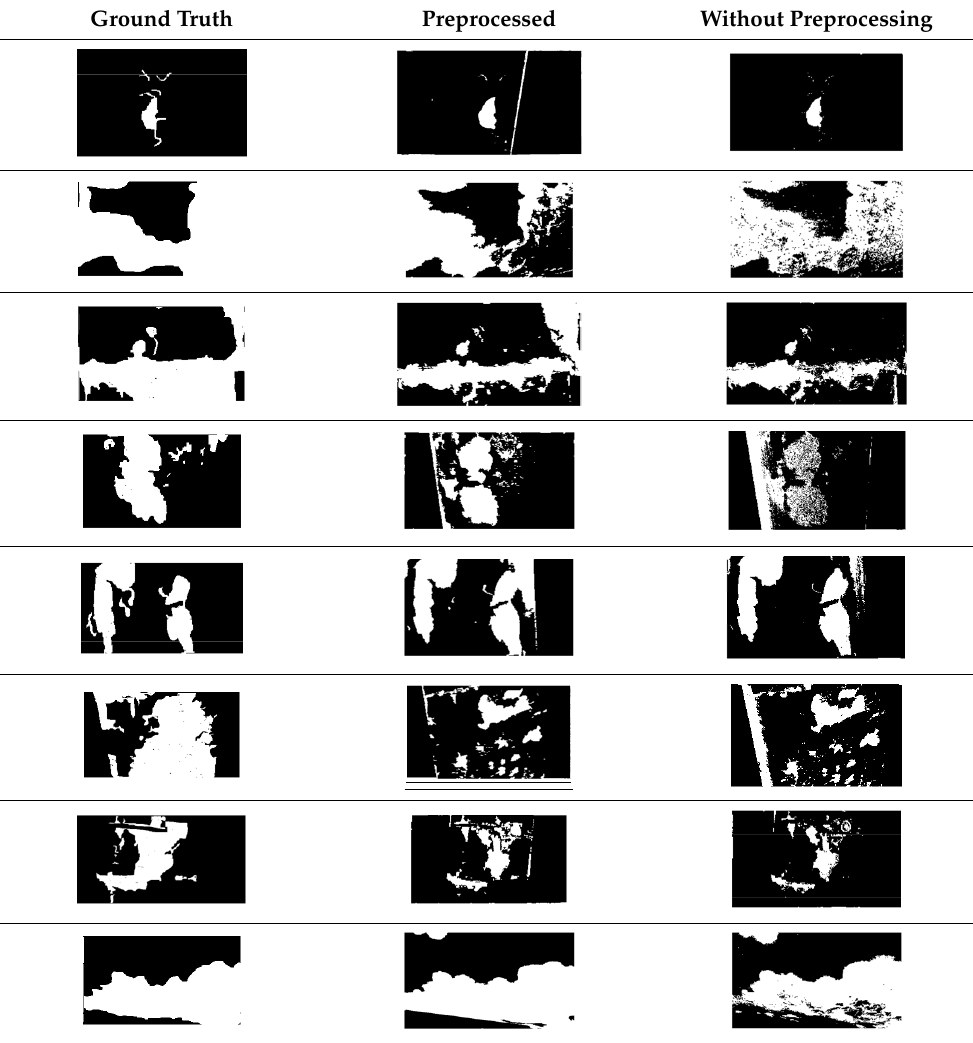
Table 6 . Comparison of a binary image with and without preprocessing . Ground Truth Preprocessed Without Preprocessing